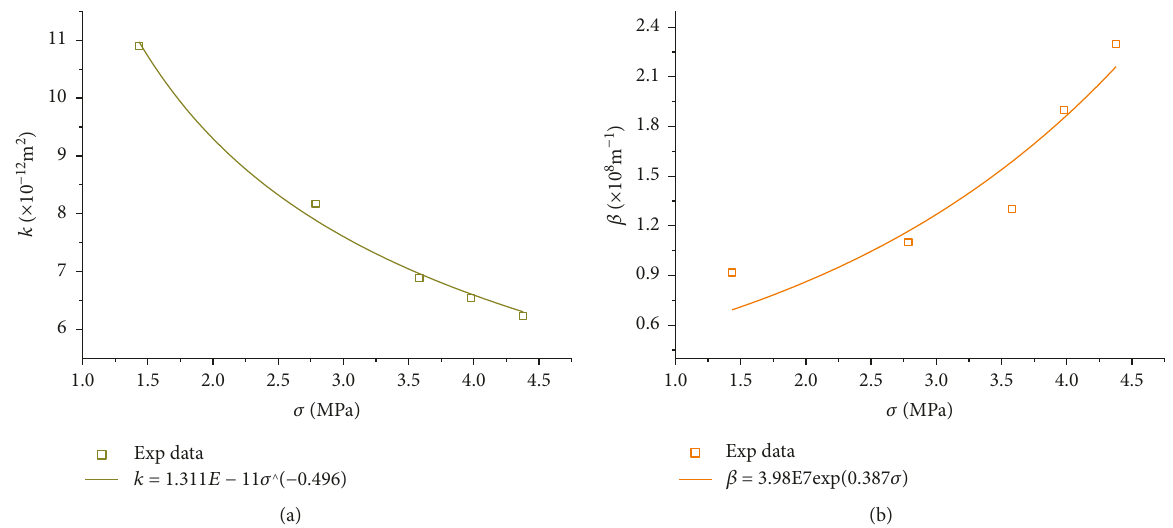
Figure 5: Relation between relative parameters: (a) the relation between permeability and stress and (b) the relation between β and